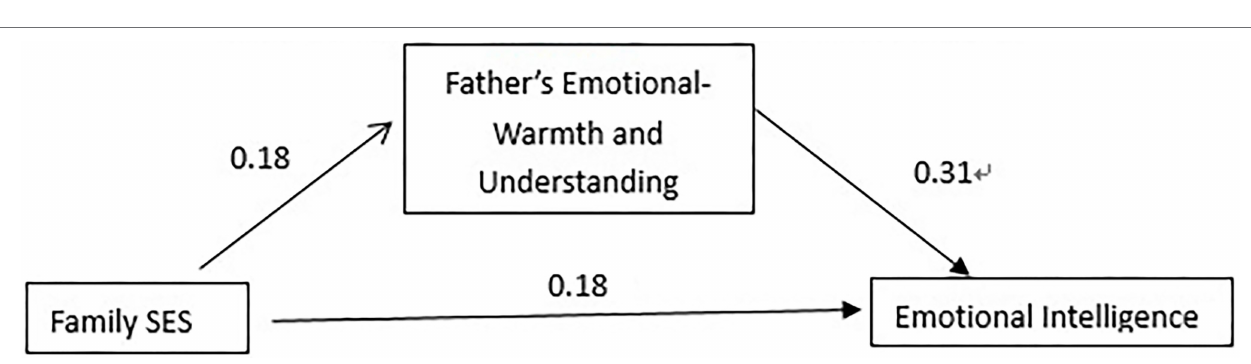
FIGURE 2 | A model diagram of the mediating effect of father’s emotional warmth and understanding in Jingzhou primary school students.